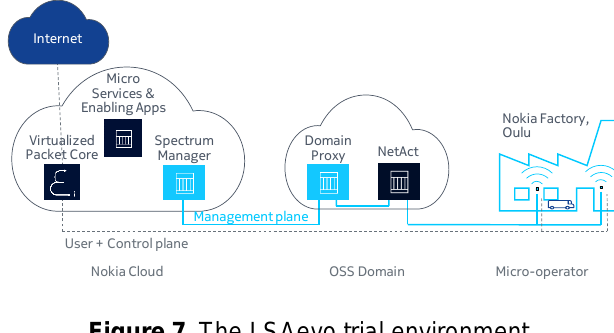
Figure 6. The LSAevo architecture reference model based on the LSA standards with CBRS extensions.